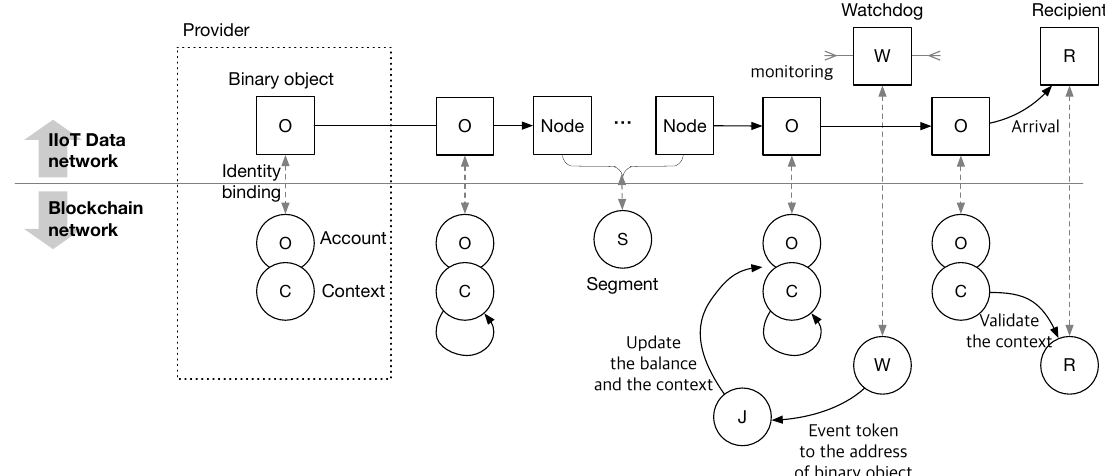
Figure 1. Overall process of I ND W ATCH . Every entity has a dual identity in the blockchain and the IIoT